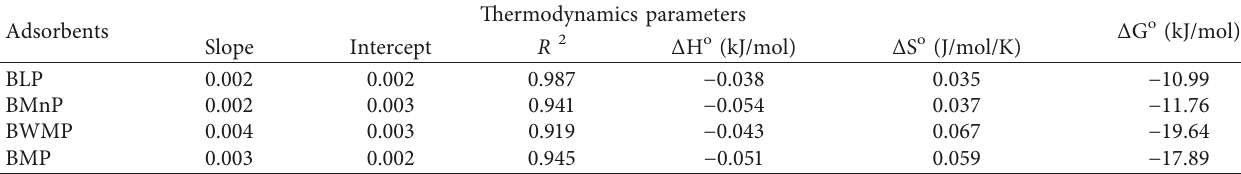
Table 6: Thermodynamics of base-treated peel samples for removal of Cr (VI).